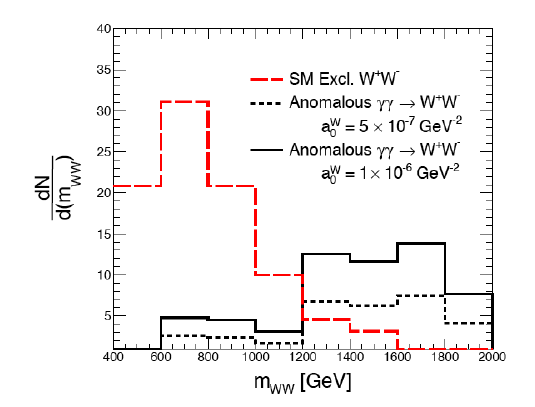
Figure 7: WW mass distribution for exclusive WW production (SM is red dashed line and anomalous couplings in full ball